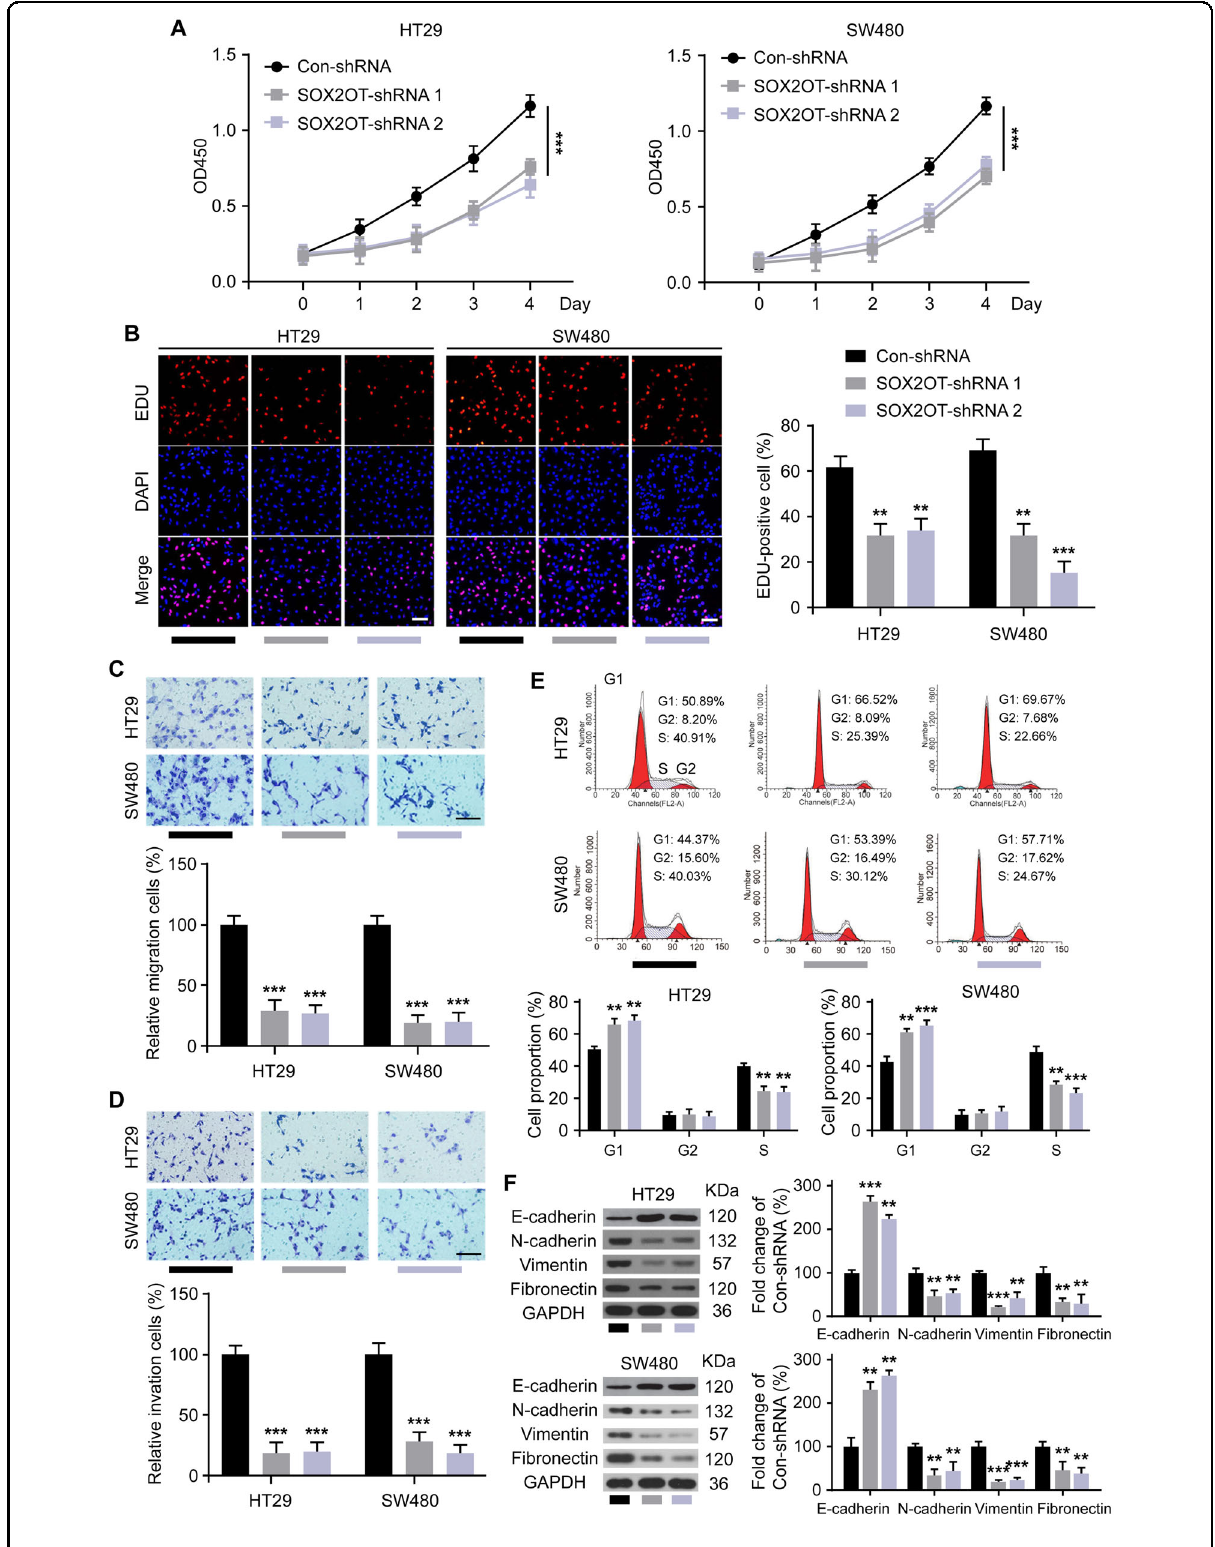
Fig. 2 (See legend on next